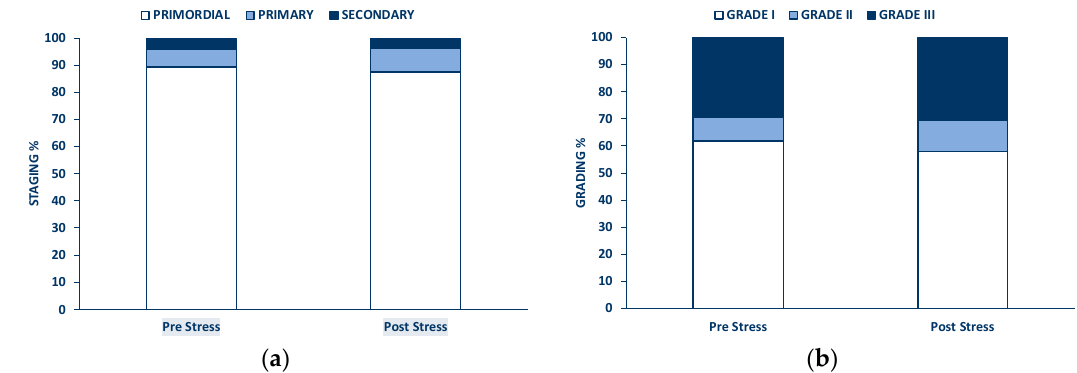
Figure 8. Histological analysis of bovine cortical ovarian tissue before and after mechanical testing: ( a ) staging of follicle growth; ( b ) grading of follicle quality.